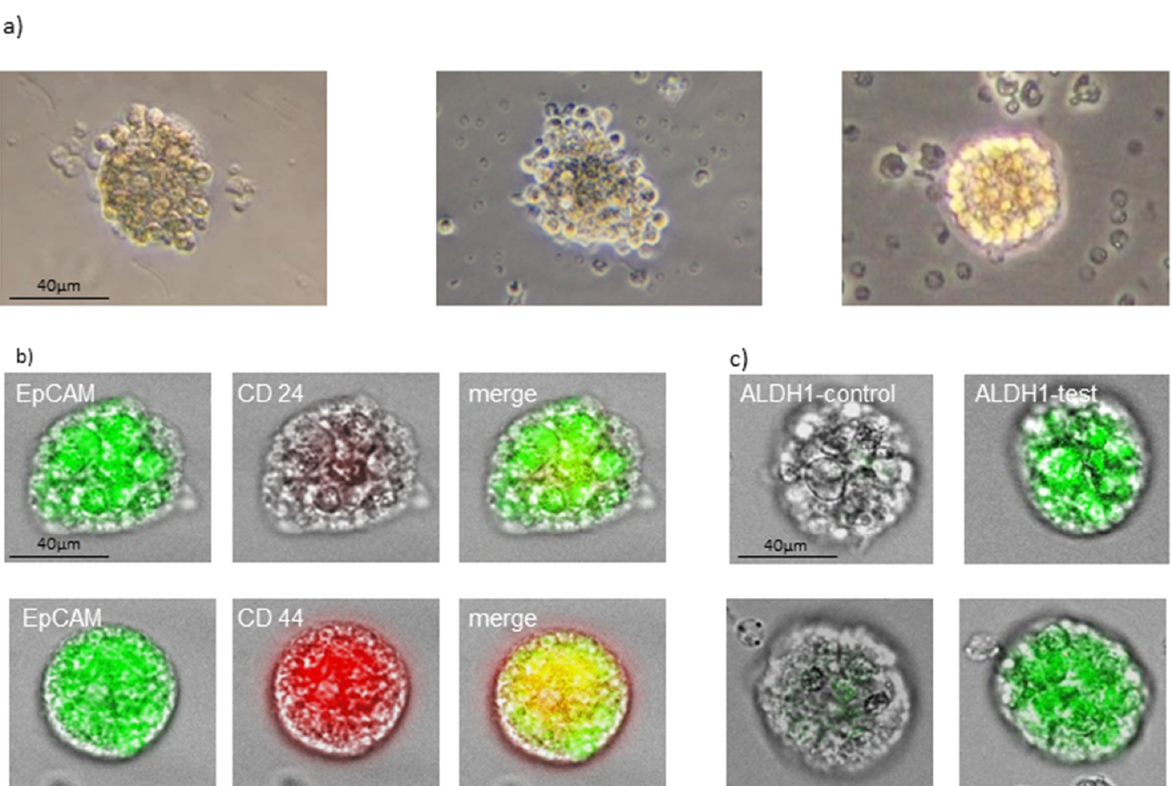
Figure 2. ( a ) Exemplary pictures of tumorspheres in light microscope. ( b ) Fluorescence staining of tumorspheres with cancer stem cell makers typical for breast cancer. ( c ) Expression of aldehyde dehydrogenase 1 (ALDH-1) in tumorspheres. Scale bar = 40 µm; magnification ×200.